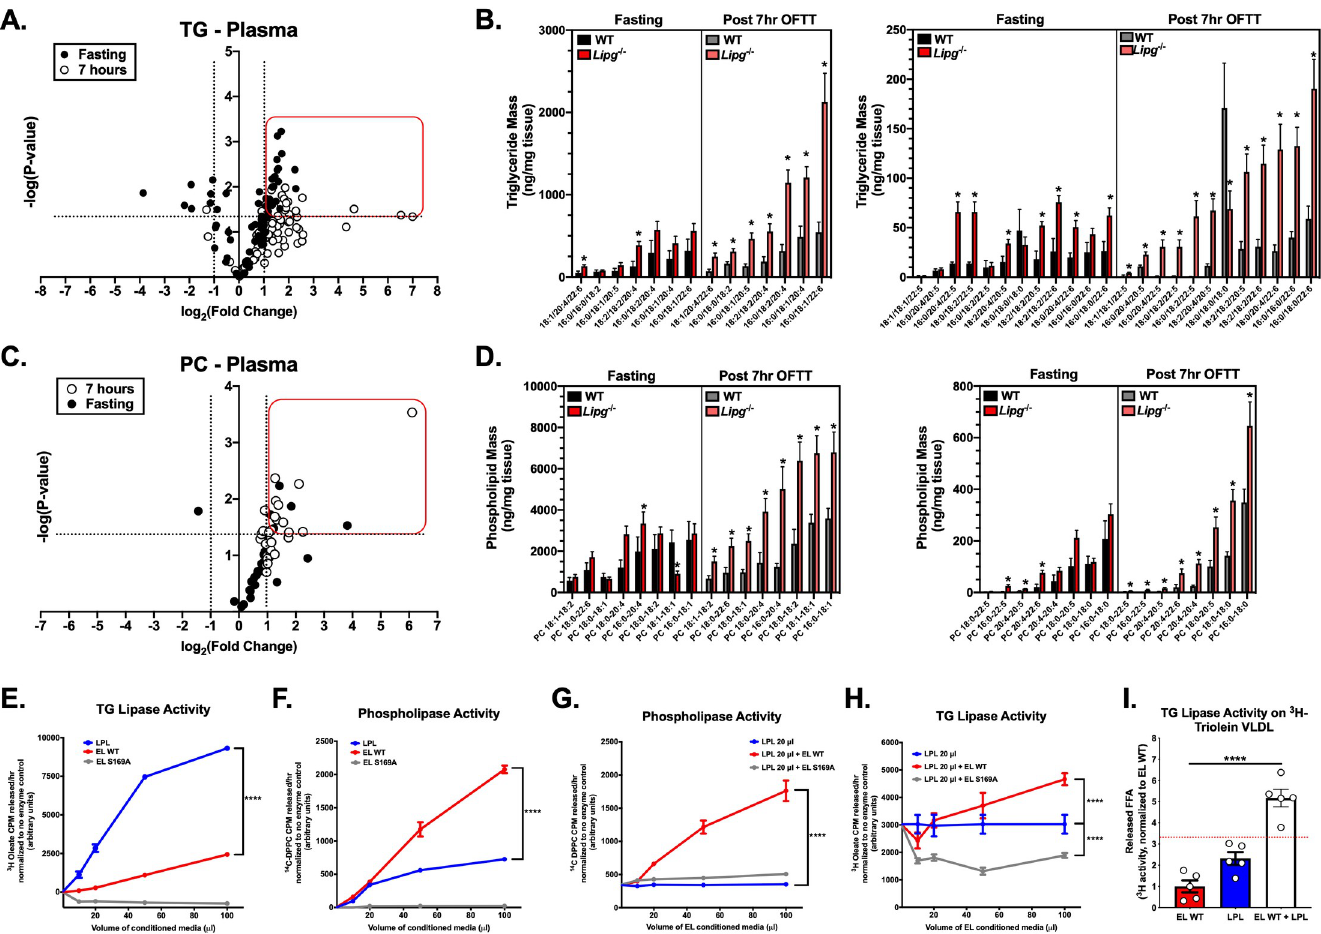
Fig 6. EL and LPL cooperate to promote TRL lipolysis in vivo . A. Volcano plot of 77 plasma triglyceride (TG) species from plasma of WT vs Lipg -/- mice after overnight fasting (filled black circles) and 7 hours (white circles) after oral fat tolerance test. Lipids were measured by liquid-chromatography tandem mass spectrometry (LC-MS) as described in the Materials and Methods. Plot shows fold change in Lipg -/- mice vs WT (x-axis; logarithmic base-2 scale) with the p-value (y- axis; logarithmic base-10 scale). Vertical dotted lines indicate two-fold change, and horizontal dotted line corresponds to P < 0.05. B. (left and right) Plasma concentration of TG species in the red line from (A) as measured by LC-MS at the indicated timepoints. C. Volcano plot of 28 plasma phosphatidylcholine (PC) species from plasma of WT vs Lipg -/- mice after overnight fasting (filled black circles) and 7 hours (white circles) after oral fat tolerance test. Lipids were measured by liquid- chromatography tandem mass spectrometry (LC-MS) as described in the Materials and Methods. D . (left and right) Plasma concentration of PC species in the red line from (C) as measured by LC-MS at the indicated timepoints. E. In vitro TG lipase activity of EL and LPL conditioned media on 3 H-triolein labeled TRL-like emulsions. Emulsions were incubated with the indicated volumes of EL or LPL-containing conditioned medium from COS7 cells infected with EL- or LPL-expressing adenovirus. Release of 3 H-oleate was used to measure TG lipase activity. F. In vitro phospholipase activity on 3 H-triolein labeled TRL-like emulsions in reactions with LPL of the indicated volume and increasing volumes of EL WT or EL S169A conditioned media. G. In vitro phospholipase activity of EL and LPL conditioned media on 14 C-DPPC-labeled TRL-like emulsions, as shown in (A-B). H. TG-lipase activity on 14 C-DPPC labeled TRL-like emulsions in reactions with LPL of the indicated volume and increasing volumes of EL WT or EL S169A conditioned media. I . TG-lipase activity on 3 H-triolein labeled human VLDLs incubated with recombinant EL WT, LPL or a combination of EL WT and LPL. Red dotted line indicates the sum of the mean activities for the EL WT (red bar) and LPL (blue bar) groups. B and C: � P < 0.05, � student’s unpaired T-test comparing the indicated groups. E-H: ���� P < 0.0001, two-way ANOVA for interaction term of indicated groups and sample volume term (X-axis). I: ���� P < 0.0001, one-way ANOVA comparing EL WT + LPL group (white bar) with other groups. Data is expressed as mean ±